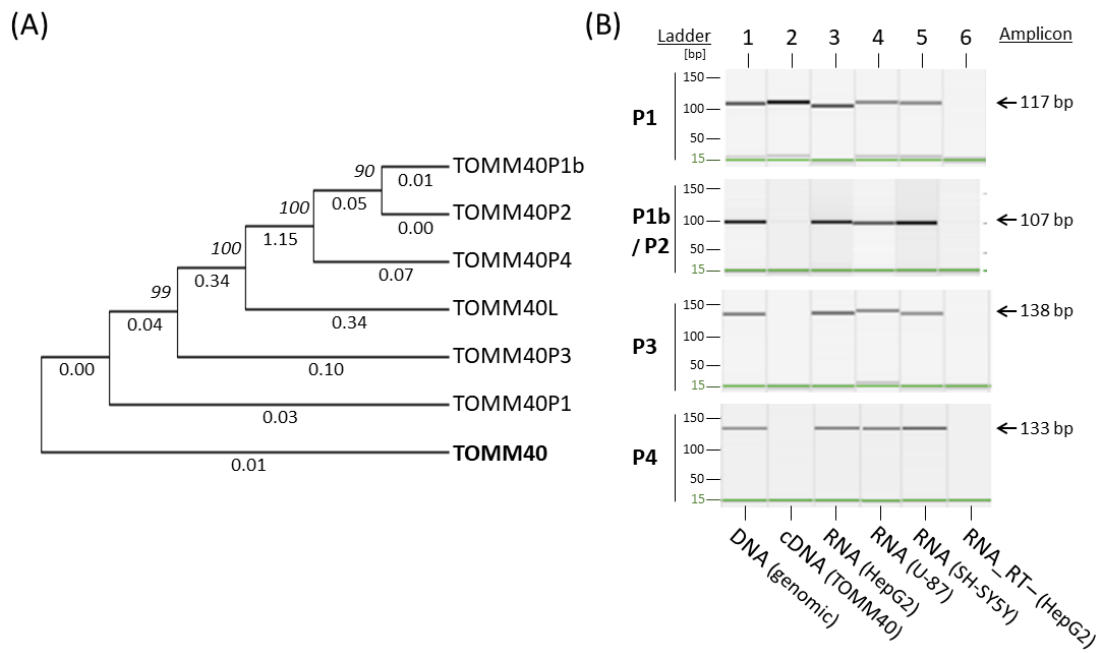
Figure 1. Phylogenetic tree evolution and end-point RT-PCR amplification of TOMM40 pseudogenes. ( A ) Phylogenetic tree structure of TOMM40- related genes and pseudogenes. Numbers above the lines are bootstrap value (or node), and numbers below the lines are substitution rate. ( B ) Capillary gel electrophoresis images of RT-PCR amplified pseudogenes from total RNA of three human cell lines (HepG2, U-87, and SH-SY5Y). Amplicons for pseudogenes P1 , P1b , P2 , P3 , and P4 are shown. Genomic DNA (lane 1) served as a positive control, TOMM40 cDNA (lane 2) served as a reference for cross-amplification, and RT- RNA (lane 6) served as a negative control.